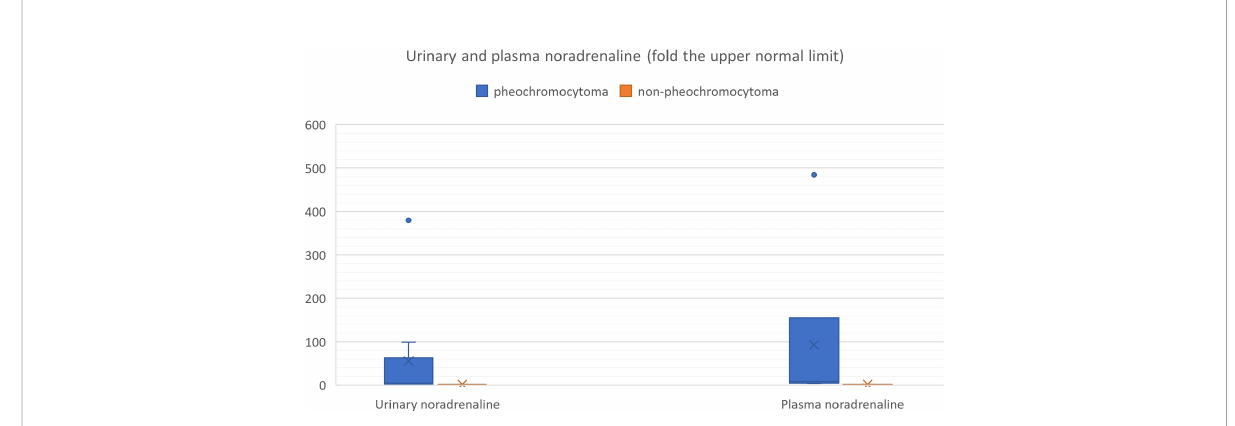
FIGURE 10 Urinary and plasma noradrenaline levels in patients with hemorrhagic pheochromocytoma and adrenal bleeding without pheochromocytoma based on the literature (3, 10, 12, 14, 20, 25 – 29, 30 – 39, 40 – 49, 50 –